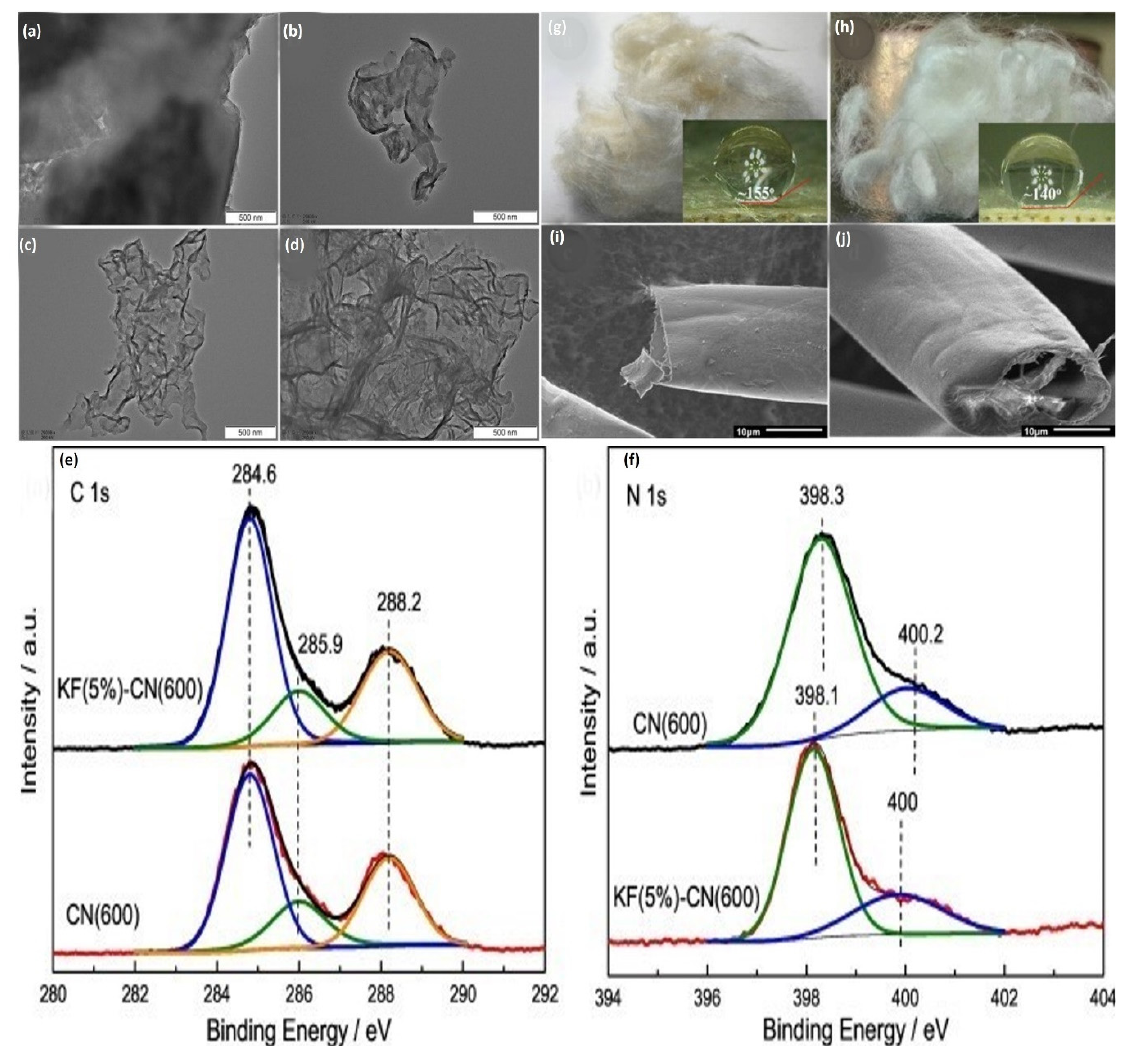
Figure 19. TEM scans of g-C 3 N 4 (600) ( a ), Kapok (1%) with g-C 3 N 4 (600) ( b ), Kapok (5%) with g- C 3 N 4 (600) ( c ), and Kapok (10%) with g-C 3 N 4 (600) ( d ). The XPS spectrum of ( e ) KF (5%)-CN (600) and